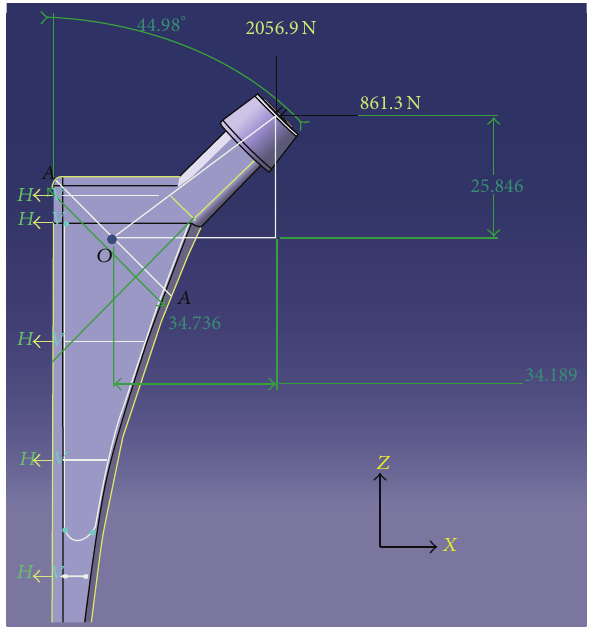
Figure 7: Muscle force components as per [17] acting at the head of the designed fully solid, customized, hip implant